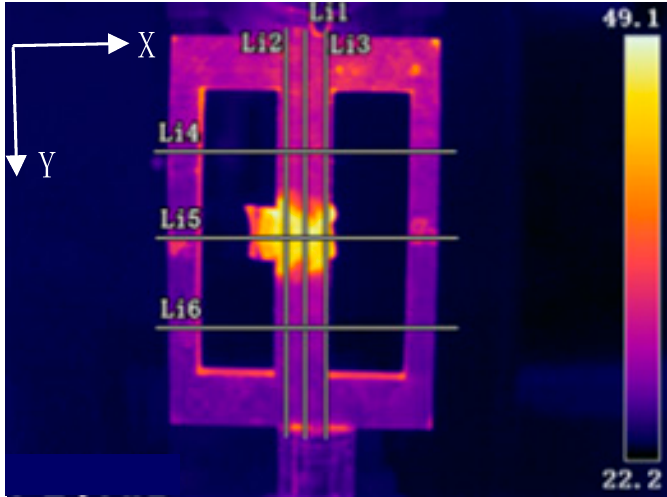
Figure 8. Observation lines for temperature during EST.